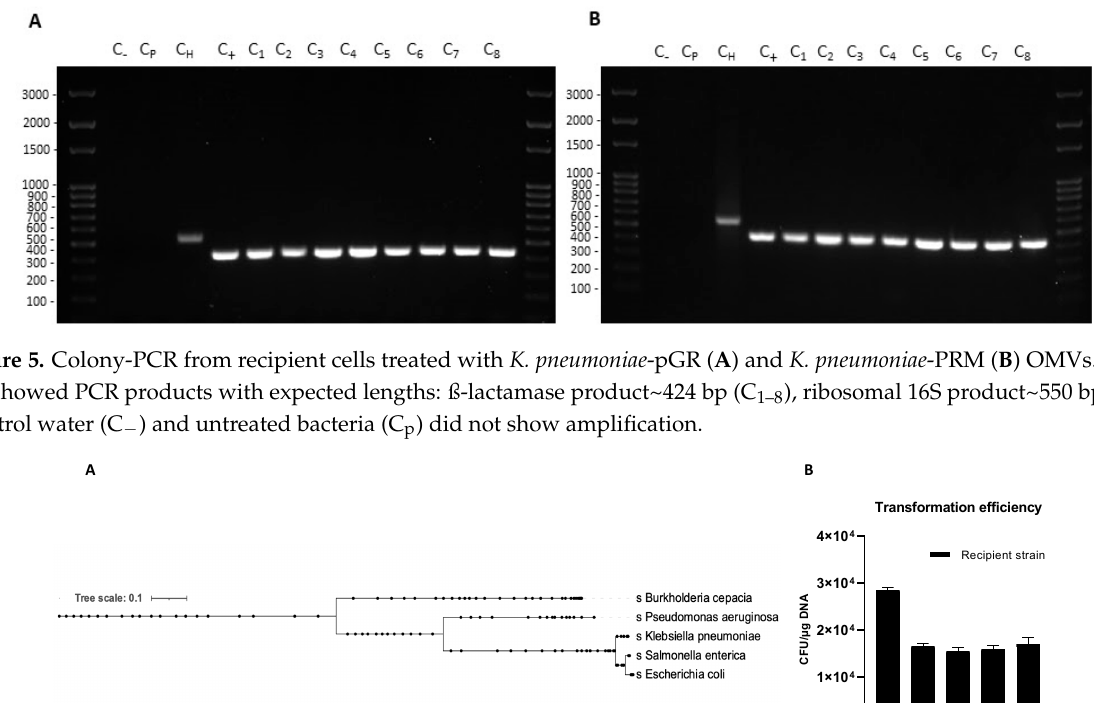
Figure 5. Colony-PCR from recipient cells treated with K. pneumoniae- pGR ( A ) and K. pneumoniae- PRM ( B ) OMVs. DNA gel showed PCR products with expected lengths: ß-lactamase product~424 bp (C 1–8 ), ribosomal 16S product~550 bp (C H ). Control water (C − ) and untreated bacteria (C p ) did not show amplification.